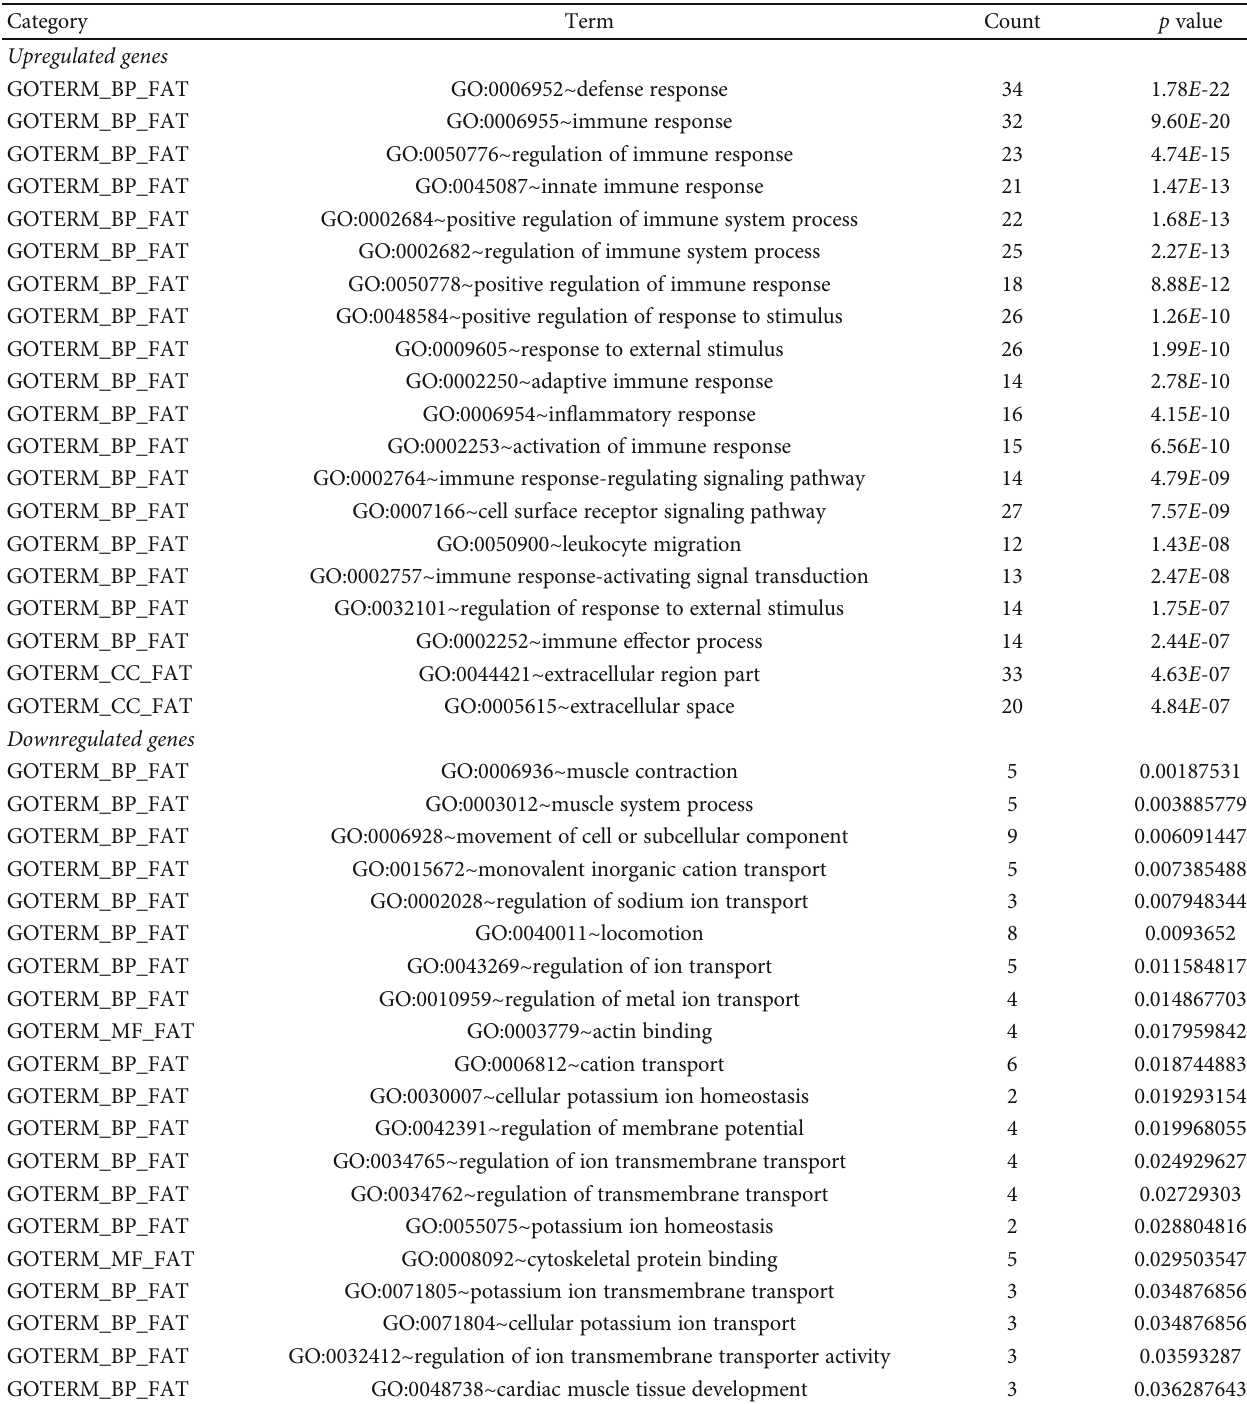
Table 2: The signi fi cant Gene Ontology enrichments of di ff erentially expressed genes (DEGs).